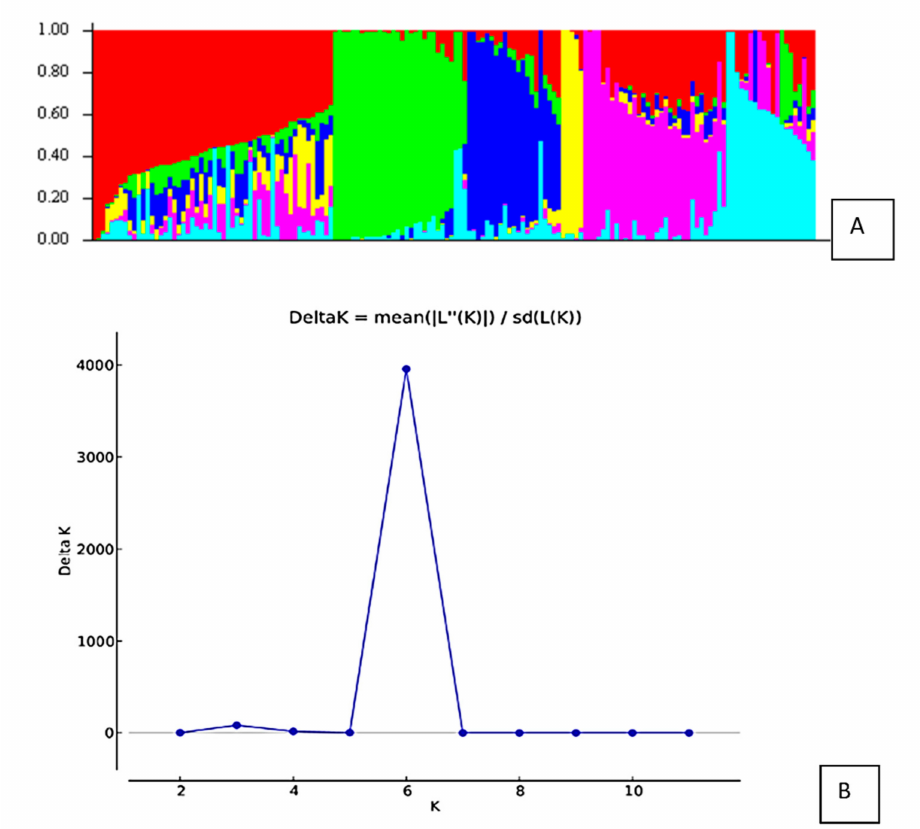
Figure 4. The six sub-populations (1 = red, 2 = green, 3i = blue, 4 = yellow, 5 = pink and 6 = teal) of the 162 early maturing yellow and white inbred lines using DArT SNP markers. ( A ) population structure bar plot of the 162 early yellow and white inbred lines as shown by 9684 DArT SNP markers for K = 6. ( B ) Assessment of the best delta K by the Evanno